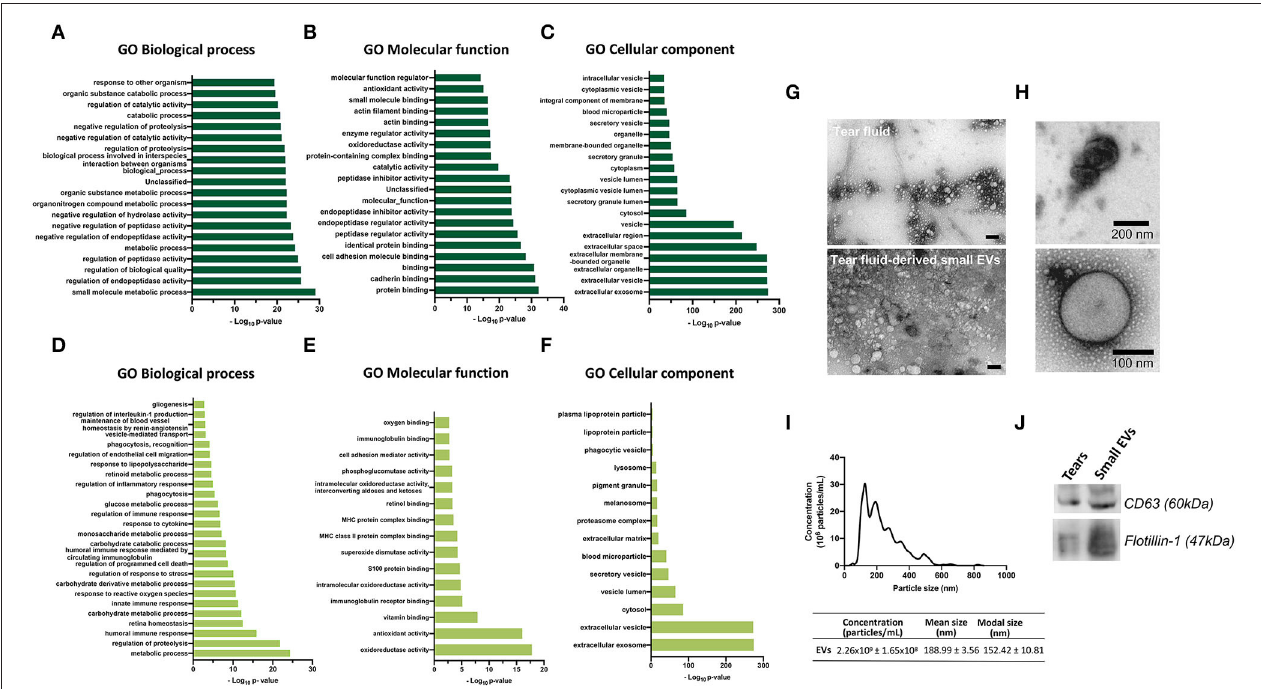
FIGURE 2 | (A–F) Gene Ontology enrichment analysis for GO biological process, molecular function and cellular component terms. Each diagram displays the bar plot of GO category terms along the y-axis and the corresponding degree of enrichment by the –log 10 ( p -value) on x-axis. Top-ranked 20 enriched significant (A) Biological processes, (B) Molecular functions and (C) Cellular components of quantified proteins by LC-MS/MS. (D–F) Enriched significant biological processes, molecular functions and cellular components of 682 quantified proteins by LC-MS/MS that might be associated with the retina. [Fischer’s exact test (FDR p < 0.05)]. (G–J) Tear fluid and tear-derived small EVs from healthy, nondiabetic subjects. (G,H) Transmission electron microscopy images showing small EVs. Small EVs were obtained using Total Exosome Isolation Reagent. Scale bar of panel G: 100nm. (I) Nanoparticle tracking analysis, showing the small EVs size distributions, mean size, modal size and concentration of particles. (J) Western blot analysis of small EVs using antibodies against CD63 and